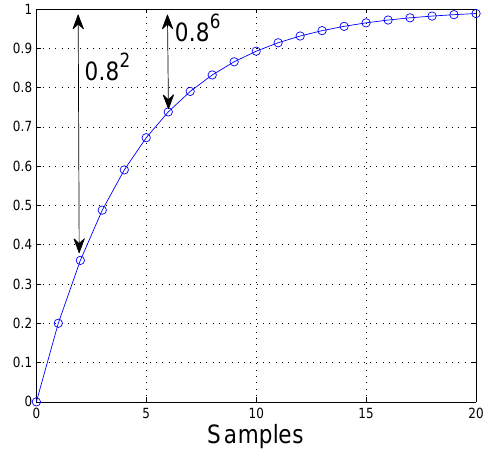
Figure 1. Target closed-loop step response with a pole of 0.8 and no